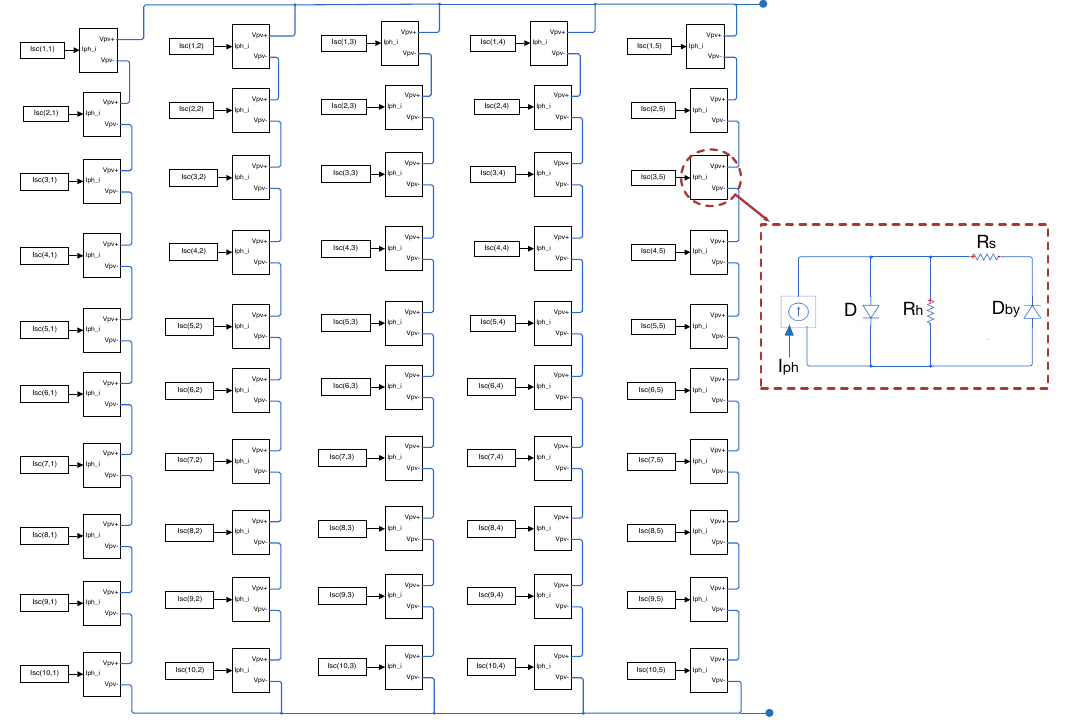
Figure 11. The PV array circuit in